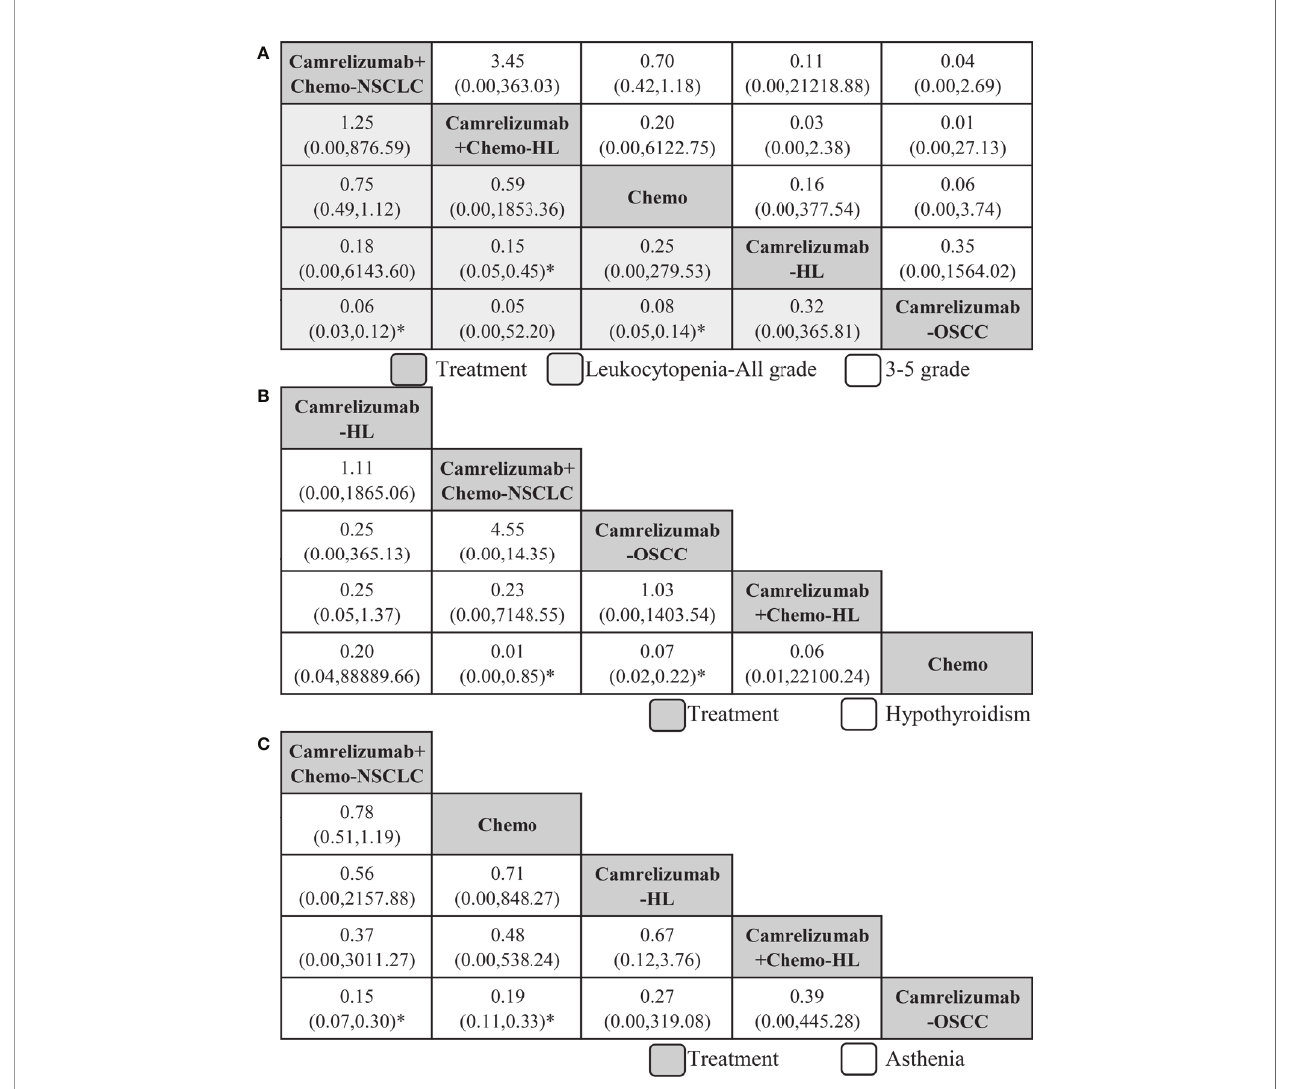
FIGURE 4 | Network meta-analysis of safety outcomes including leukocytopenia (A) , hypothyroidism (B) , and asthenia (C) . From right to left, treatments are ranked by mean rank and SUCRA score. Comparisons between treatments should be read from right to left, and the estimate is in the cell in common between the column- de fi ning treatment and the row-de fi ning treatment, and an OR less than 1 favors the row-de fi ning treatment. To obtain OR for comparisons in the opposing direction, reciprocals should be taken. Chemo, chemotherapy; HL, Hodgkin lymphoma; OSCC, esophageal squamous cell carcinoma; NSCLC, non-squamous non-small-cell lung cancer. *Signi fi cant